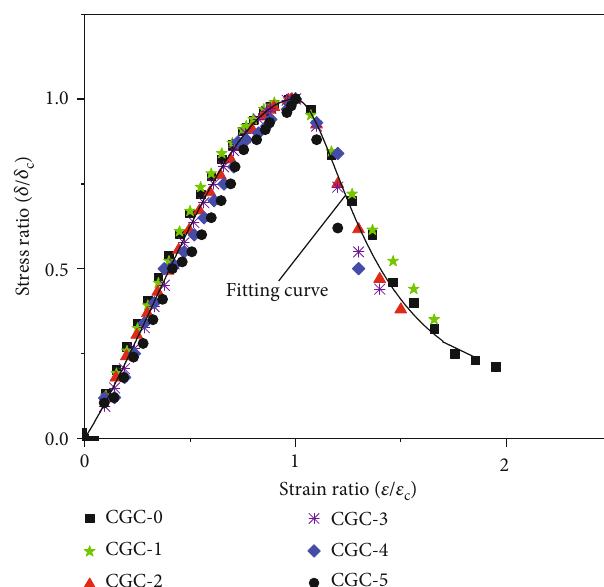
Figure 9: Fitting curve of the stress-strain constitutive equation of